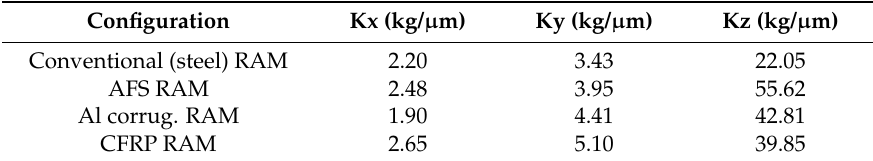
Table 4. FE results: the structure stiffness comparison in the X , Y , and Z directions. Configuration